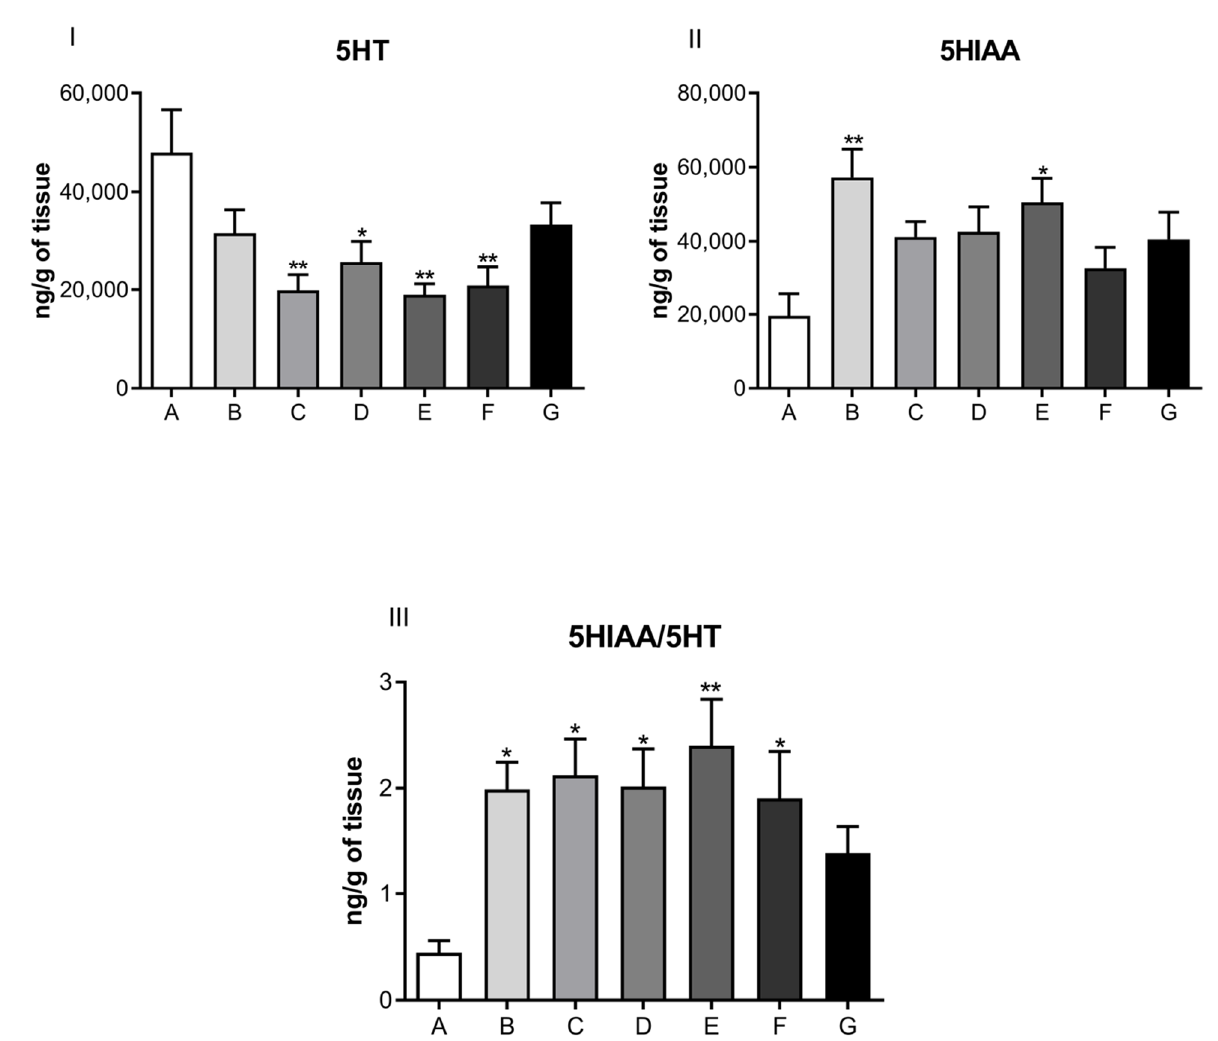
Figure 6. Neurotransmitter levels related to the serotonergic system in the cardiac muscle of dams submitted to the postpartum depression model, treated or not with different doses of ketamine in- traperitoneally. Panel ( I ): serotonin (5HT) levels (ng/g); Panel ( II ): serotonin metabolite 5-hydroindole, 3-acetic acid (5HIAA) levels (ng/g); Panel ( III ): ratio of 5HIAA/5-HT (ng/g). A—control group (normal, not treated); B—control and treated with saline; C—depressed and treated with saline; D—depressed + ketamine 5 mg/kg; E—depressed + ketamine 10 mg/kg; F—depressed + ketamine 20 mg/kg; G—depressed + single dose of ketamine 10 mg/kg group. The means and the respective standard errors are presented. N = 10. Animals per group * p < 0.05, ** p < 0.01, and *** p < 0.001 one-way ANOVA followed by Bonferroni test.